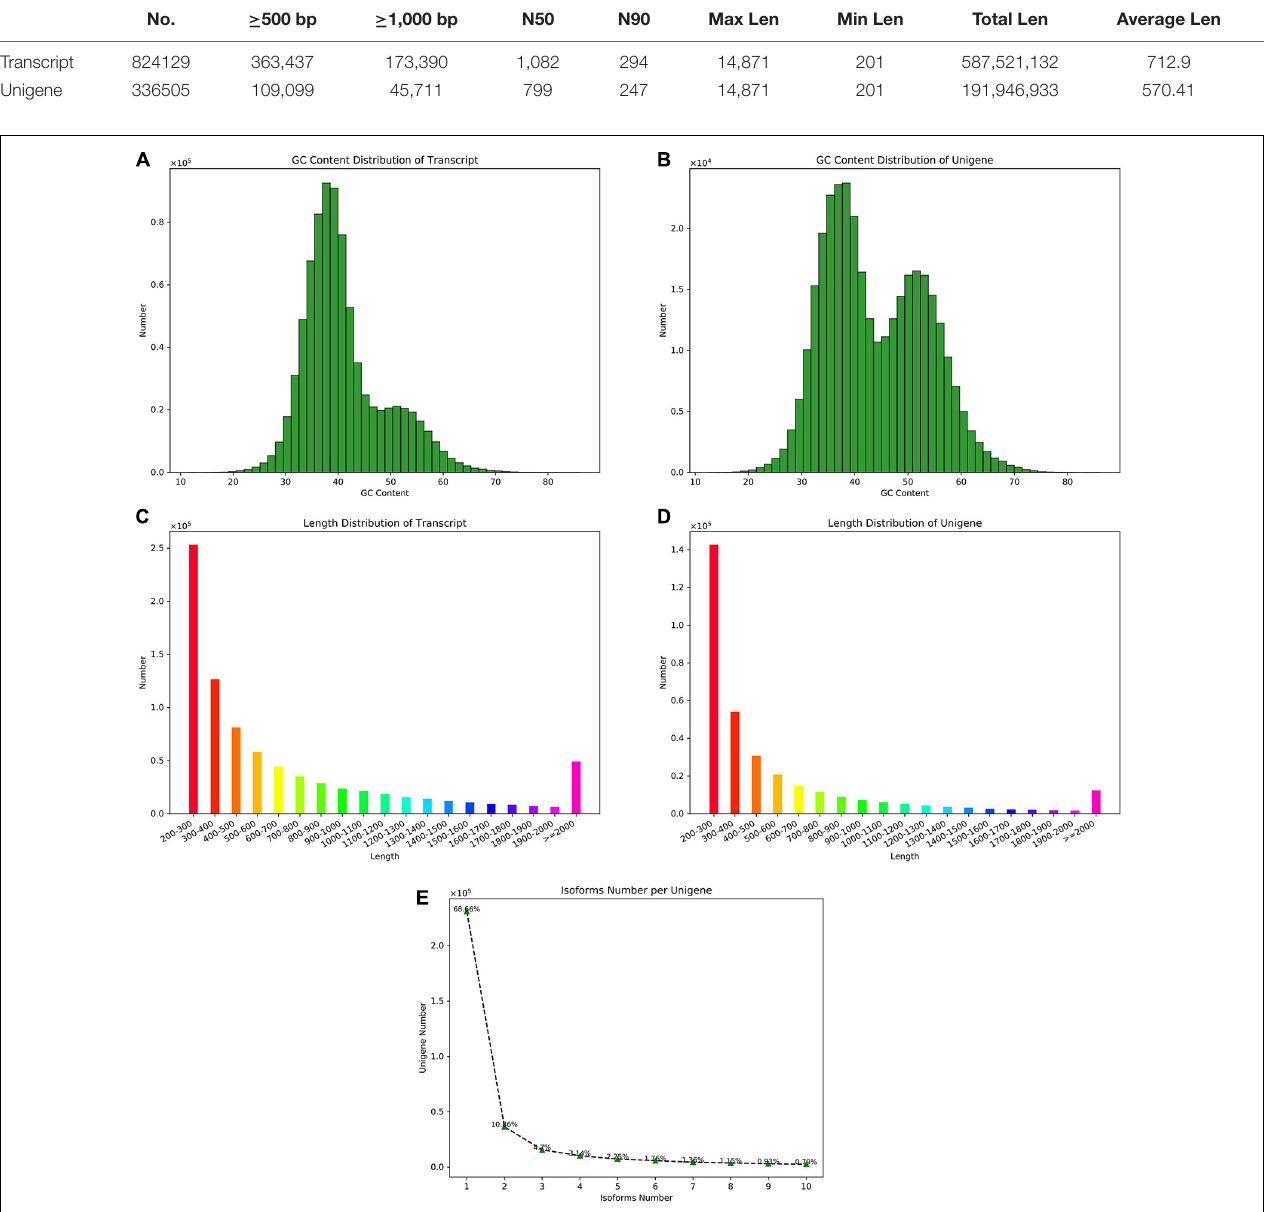
TABLE 1 | The detailed information of the spliced transcripts and unigenes.